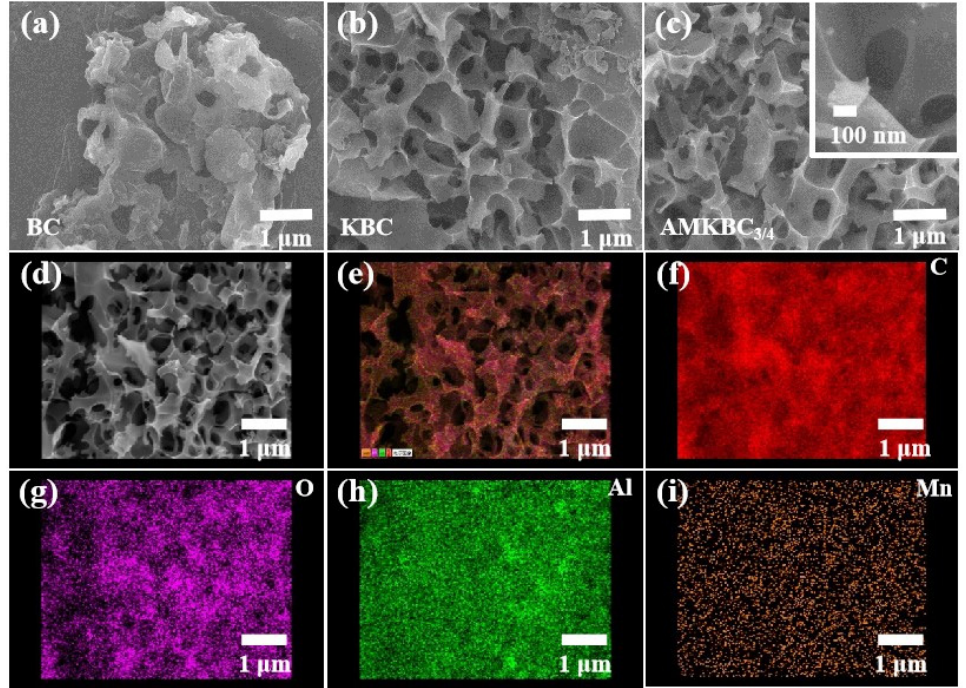
Figure 2. SEM images of BC ( a ), KBC ( b ) and AMKBC 3/4 ( c , d ); EDS merged image of total elements ( e ); the distribution maps of C ( f ), O ( g ), Al ( h ), and Mn ( i ) for AMKBC 3/4 .